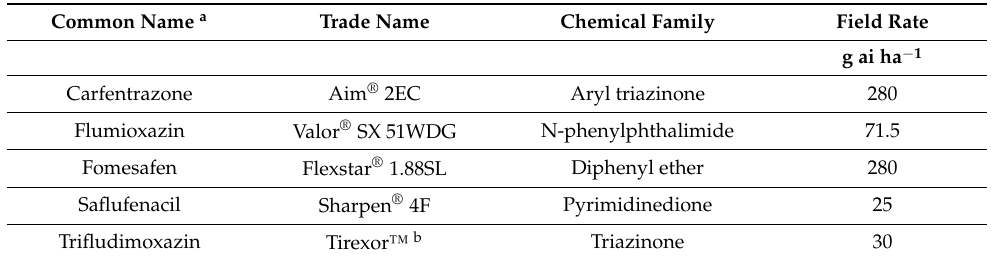
Table 2. Common name, trade name, and chemical family of PPO-inhibiting herbicides in the study. Common Name